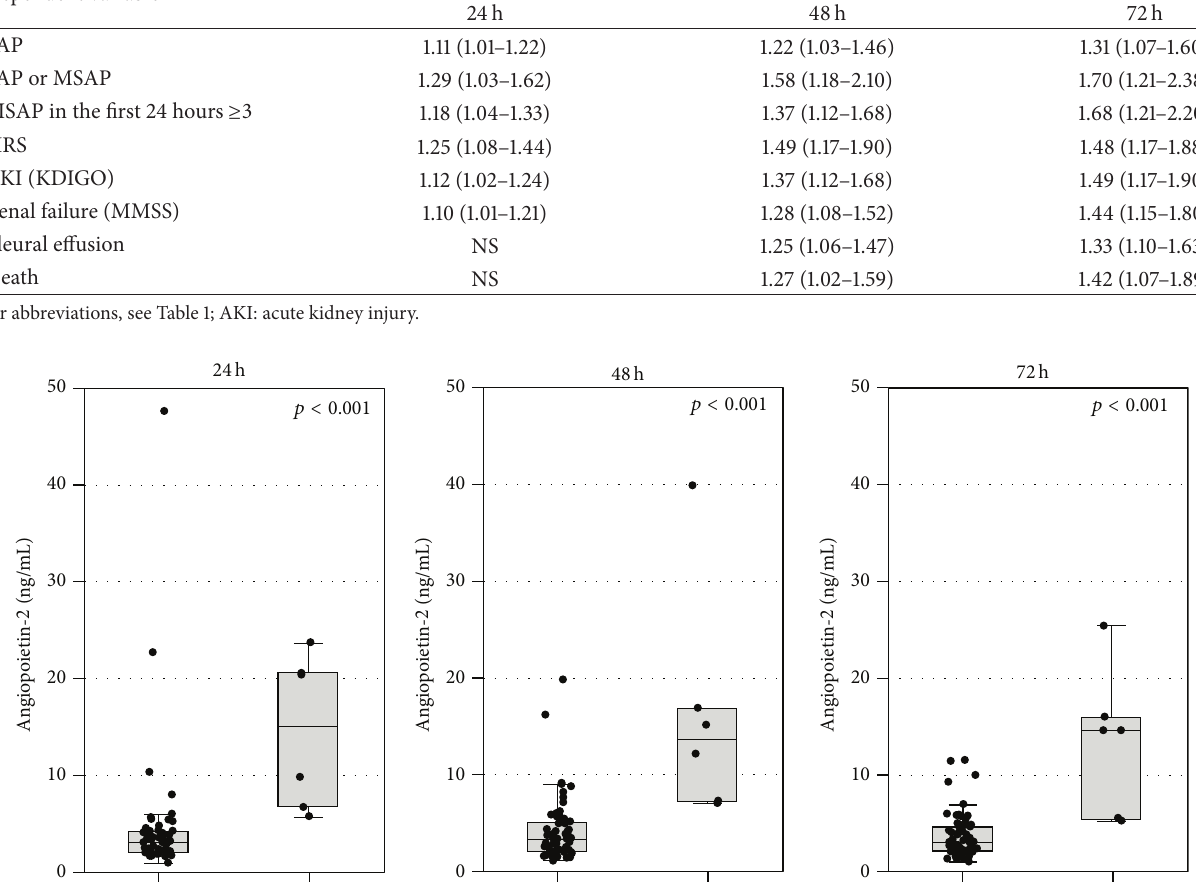
Table 3: Angiopoietin-2 serum concentrations as a predictor of the severity of acute pancreatitis—results of simple logistic regression. Dependent variable